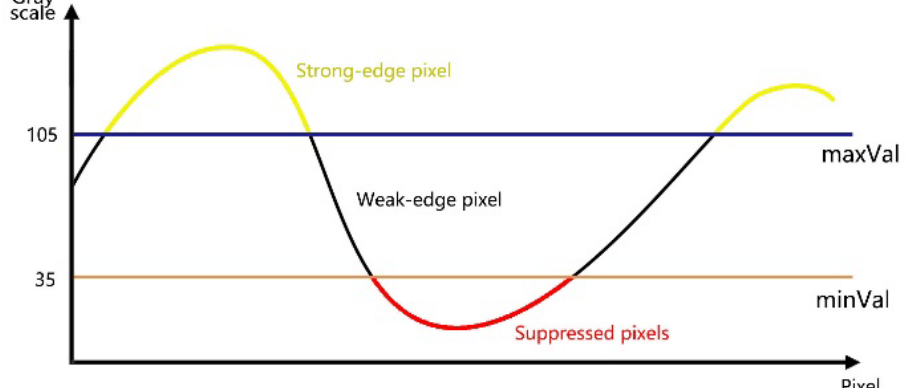
Figure 3. Displaying the hysteresis threshold, when pixel values greater than maxVal are flagged as strong edges; pixel values less than maxVal and greater than minVal are flagged as weak edges; pixel values less than minVal are suppressed.